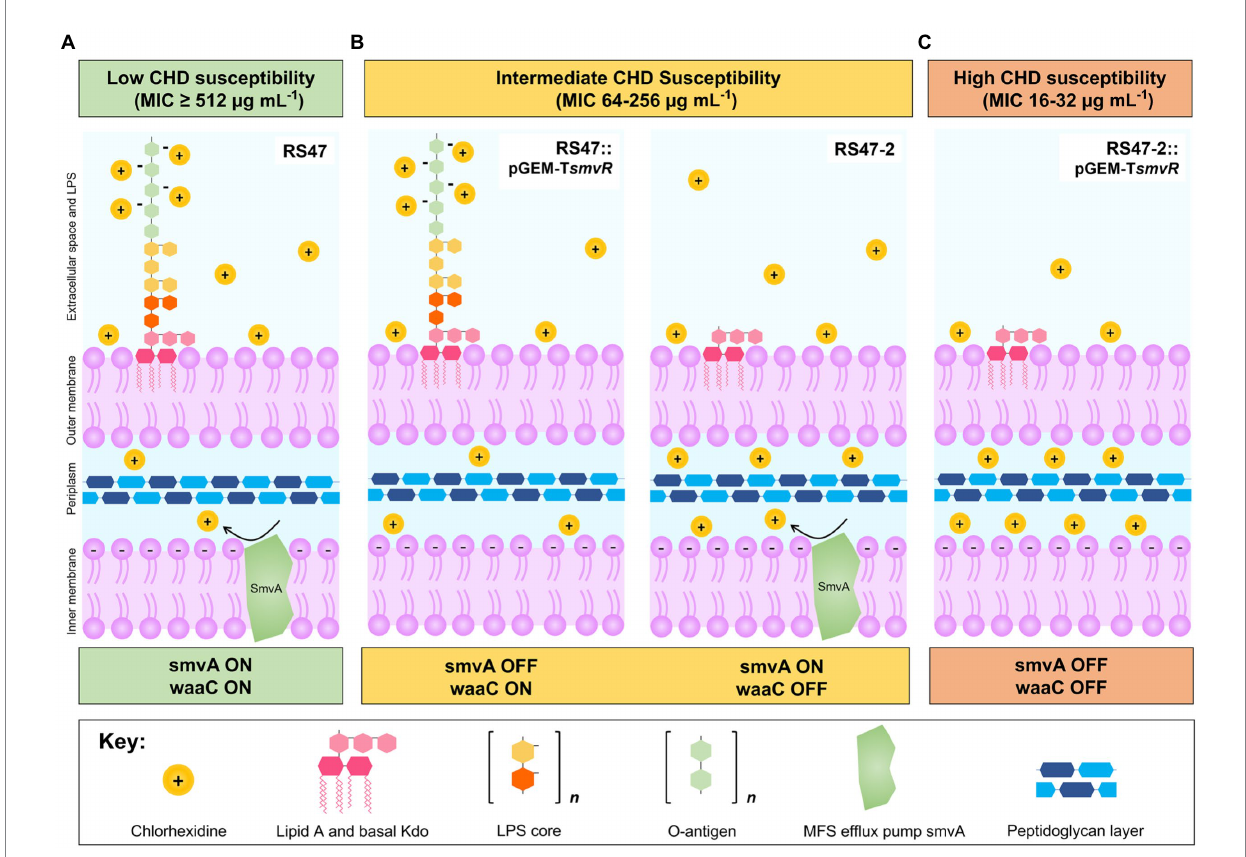
FIGURE 6 Overview of mechanisms modulating CHD susceptibility in Proteus mirabilis . (A) Low susceptibility to CHD is conferred by LPS structure and smvA efflux in WT P. mirabilis clinical isolate RS47 ( smvA on, waaC on). Positively charged CHD molecules are occluded by negative charges on the LPS while smvA mediated efflux provides further protection from CHD that enters the periplasmic space. (B) Intermediate susceptibility to CHD is conferred by variation in LPS structure or inactivation of smvA efflux activity, observed in RS47::pGEM-T smvR ( smvA off, waaC on) and RS47-2 ( smvA on, waaC off) respectively. Intact LPS in RS47::pGEM-T smvR occludes entry of CHD into the periplasmic space but subsequent protection from smvA efflux is absent. Truncation of LPS in RS47-2 increases penetration of CHD into periplasmic space, but some protection is still provided by smvA efflux. (C)